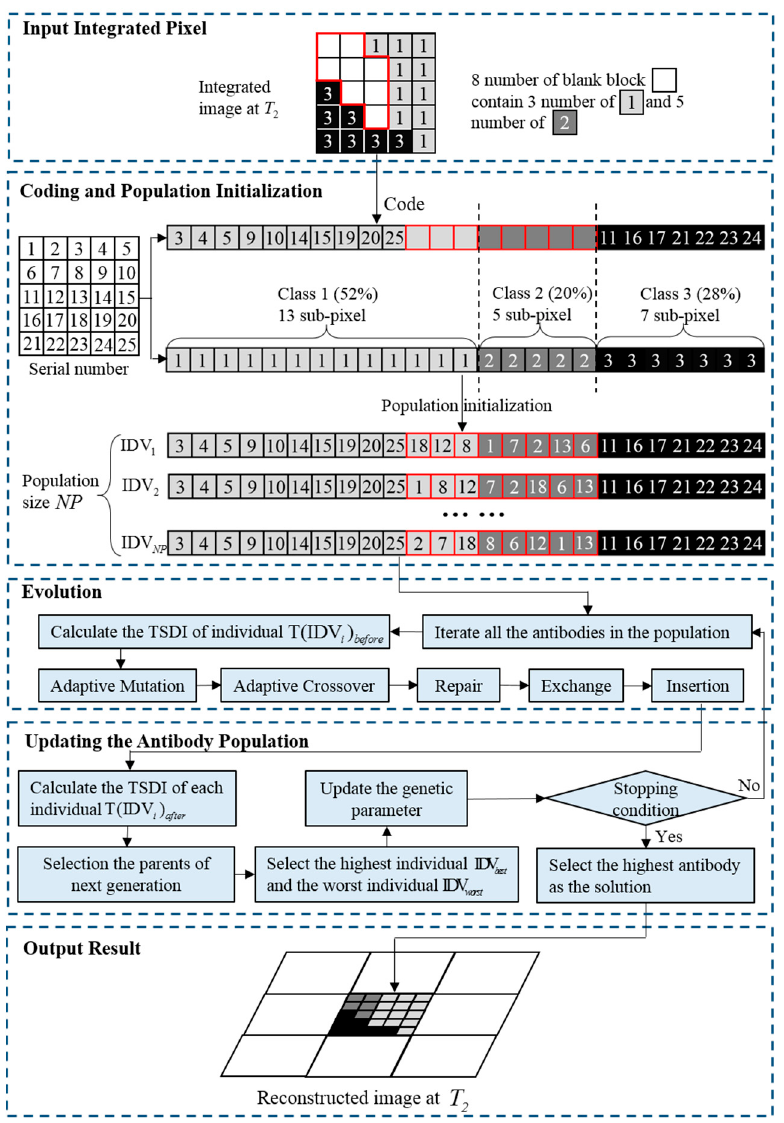
Figure 8. The framework of spatial-temporal sub-pixel mapping based on differential evolution.